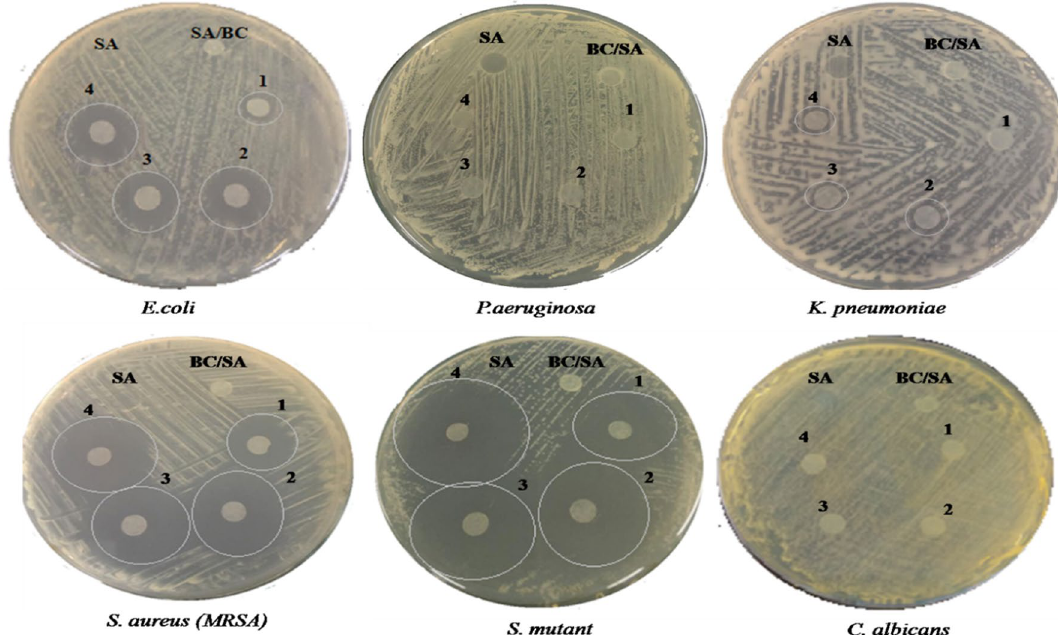
Figure 8. Disk diffusion method for antimicrobial activity expressed as halo zones of the prepared BC/SA/ GM composite at four GM concentrations 1 (0.025), 2 (0.050), 3 (0.075), and 4 (0.100) against six pathogenic